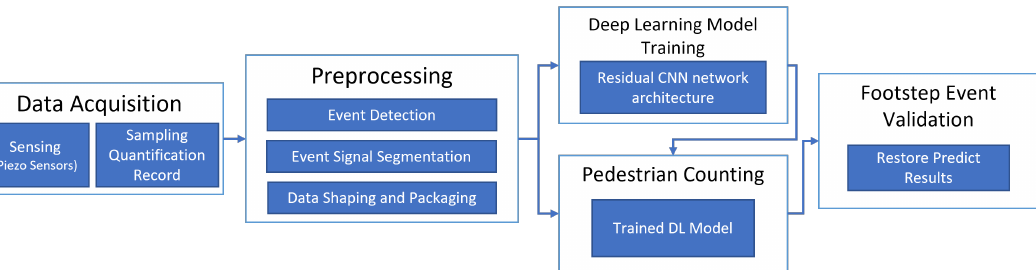
Figure 4. System architecture. The footstep event validation is as shown in Figure